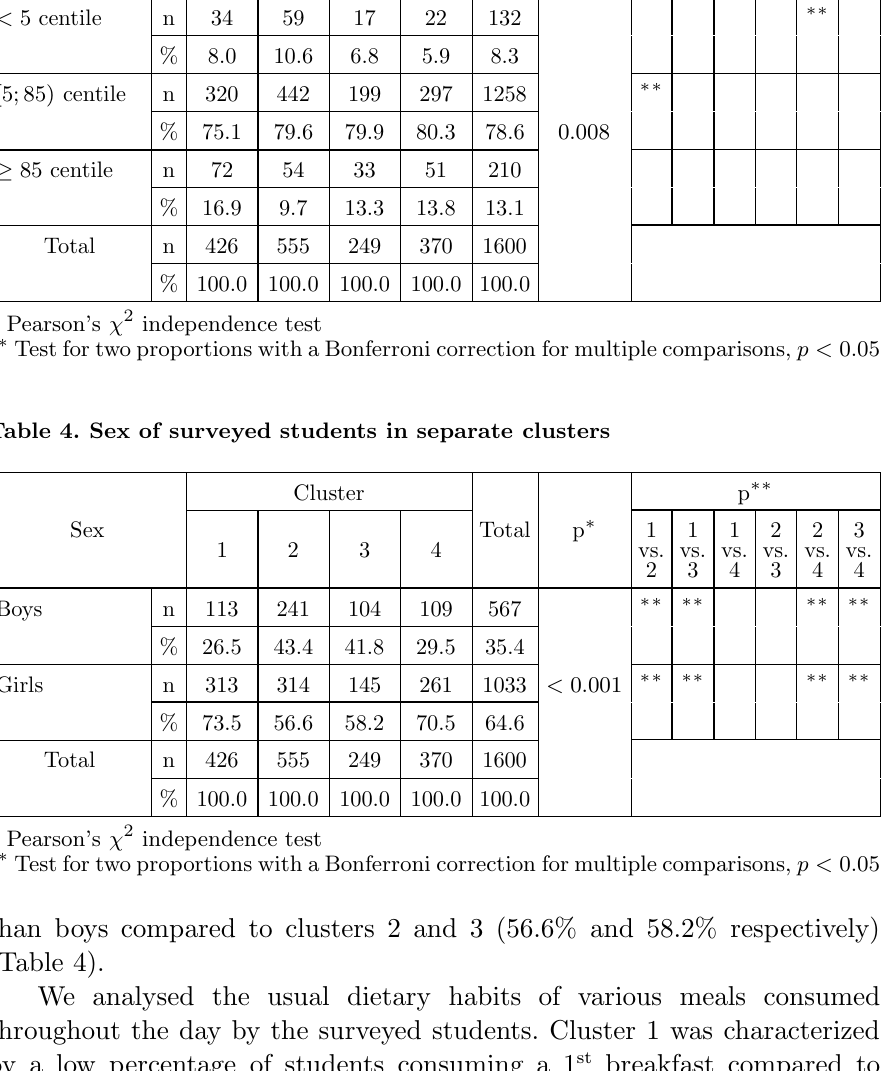
Table 3. BMI of surveyed students in separate clusters Cluster p ∗∗ BMI category Total p ∗ 1 1 1 2 2 3 1 2 3 4 vs. vs. vs. vs. vs. vs. 2 3 4